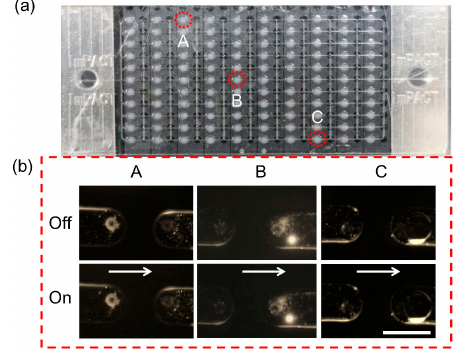
Figure 5. Confirmation of valve action by observing motion of flow containing 1- µ m-diameter